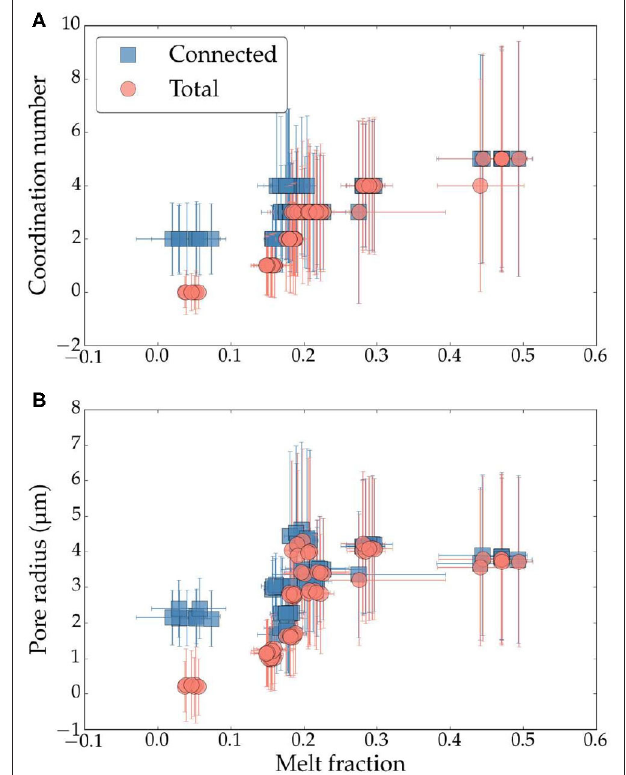
FIGURE 5 | Plots of (A) connected melt volume fraction (B) ratio between connected and total melt volume fraction as a function of total melt volume fraction in all subvolumes. In (A) , the dashed line indicates 1:1 correlation. Errorbars for melt volume fraction are given by the difference between automatically thresholded and manually thresholded melt fractions.